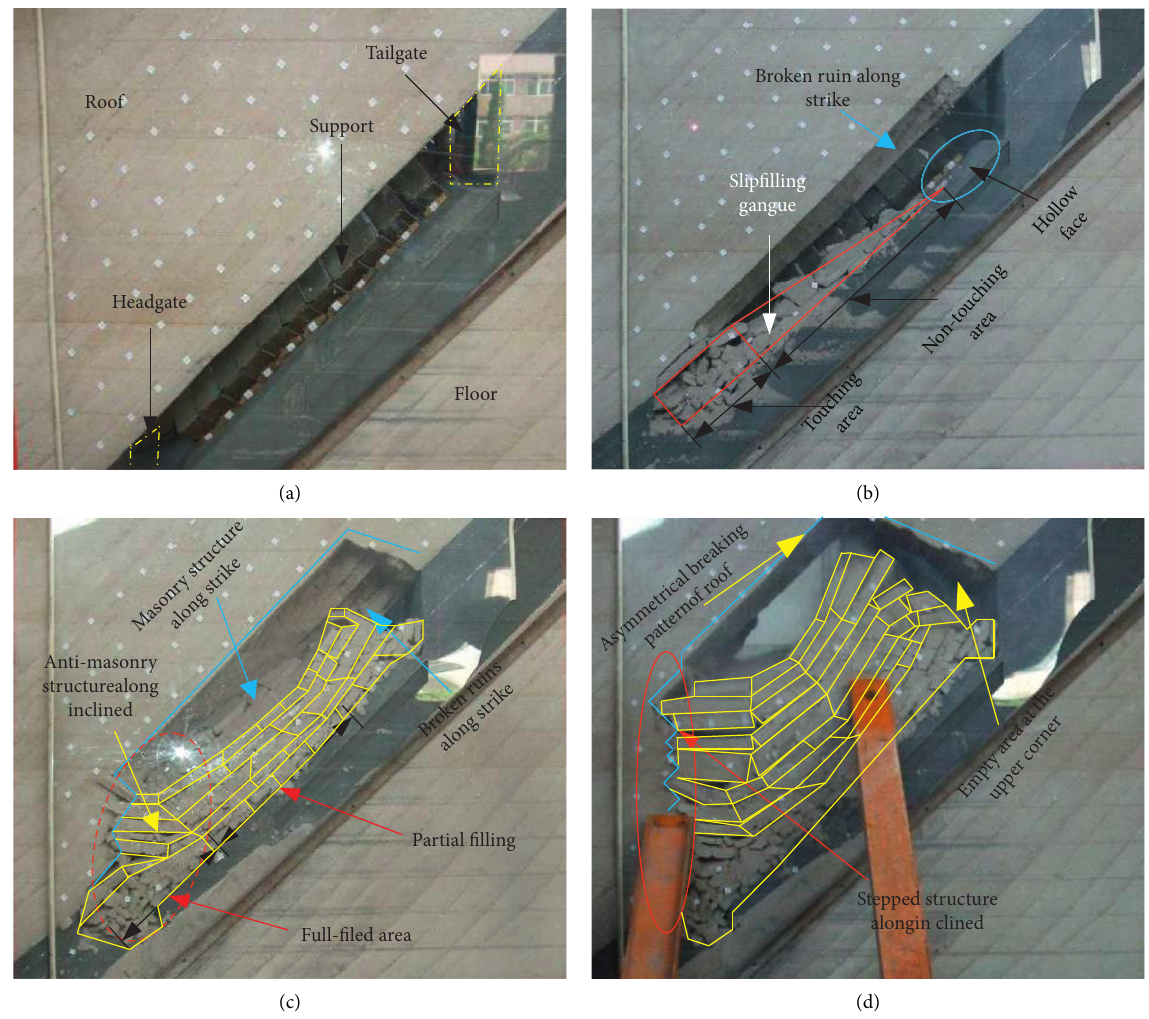
Figure 3: Characteristics of caving and filling of